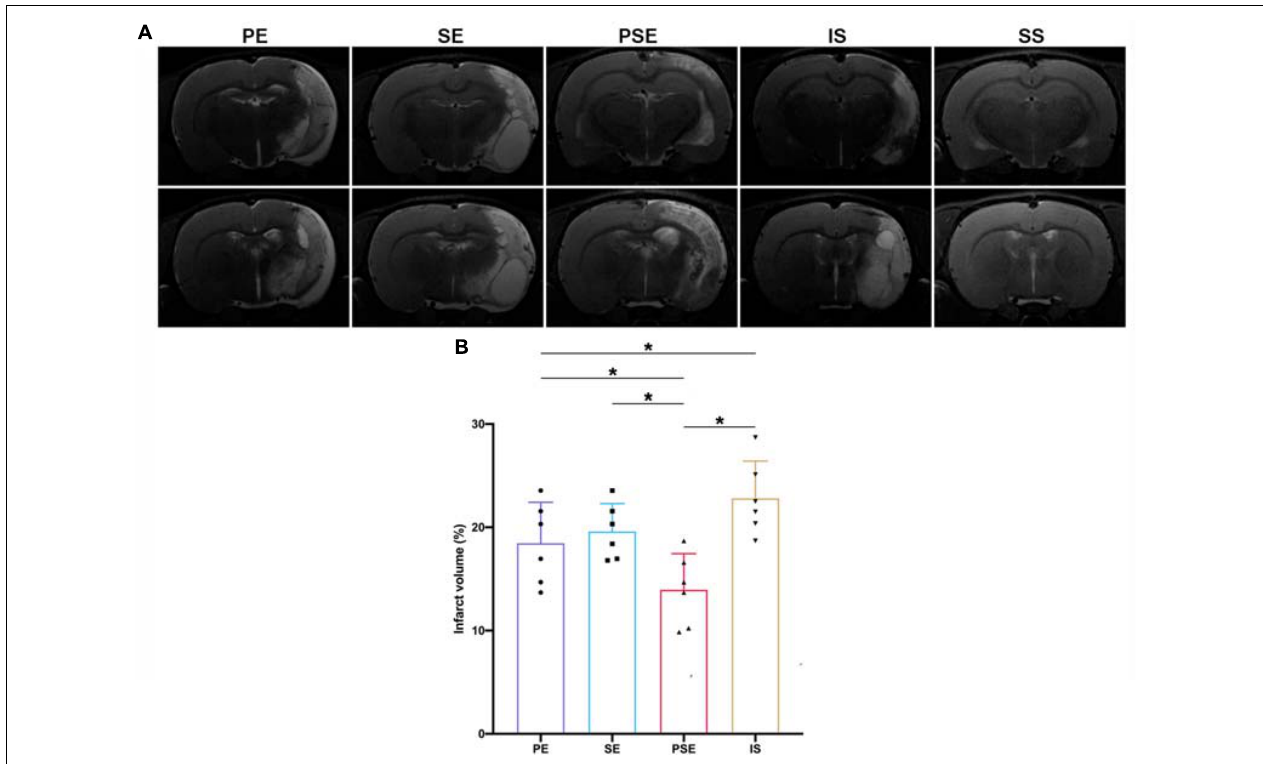
FIGURE 3 | Infarct volumes. (A) Representative images of different groups in T2 MRI scans at 14 days after stroke. Bregma levels were –2.8 mm (the upper row) and –5.2 mm (the lower row). (B) Quantitative analysis of infarct volumes according to T2 scans in four groups. n = 6. Data are expressed as mean ± SEM; * P <